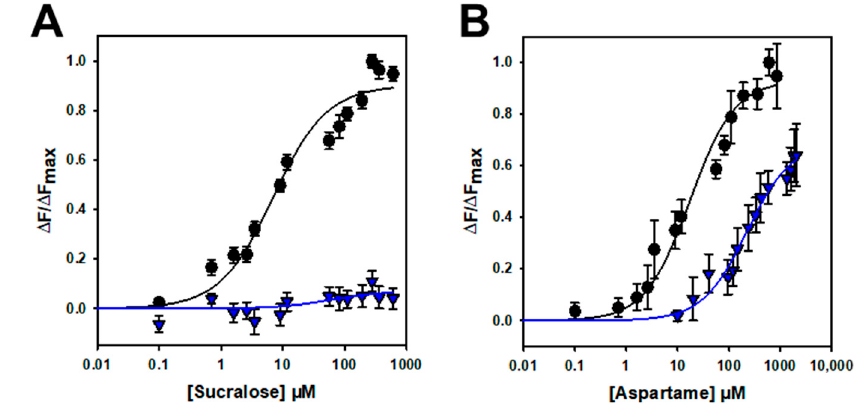
Figure 5. Titration curves of hTAS1R2-VFT-D278A (blue triangles) and hTAS1R2-VFT (black circles) with sucralose ( A ) and aspartame ( B ). Circles and triangles show experimental data, while the solid lines are the computed binding curves. Wild-type receptor dose–responses are the same as for Figure 4. Data points correspond to the means ± SEMs of at least 12 independent replicates of at least three independently refolded protein